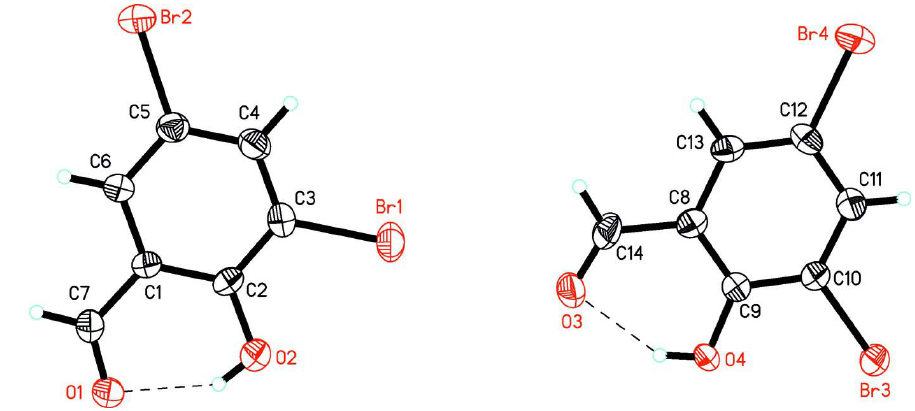
Figure 1 An ORTEP drawing of the title compound with the atom-numbering scheme. Displacement ellipsoids are drawn at the 30% probability level.